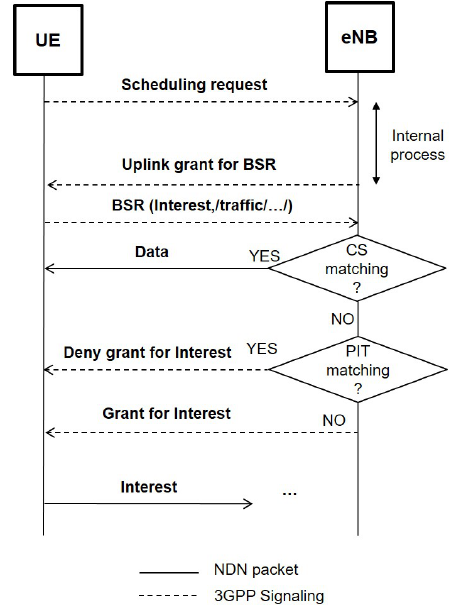
Figure 3. Proposed signaling workflow for name-aware resource